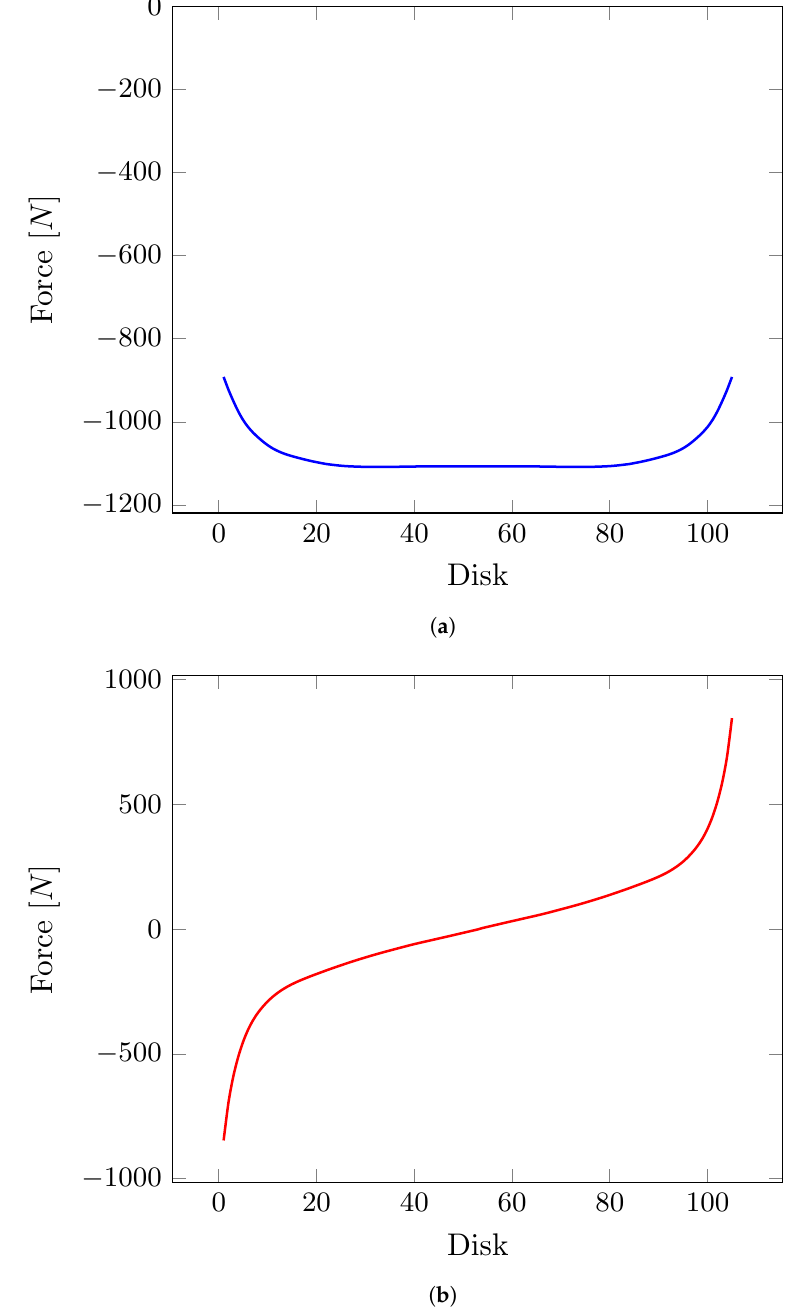
Figure 5. Forces on Phase A high-voltage winding. ( a ) Radial force; ( b ) Axial